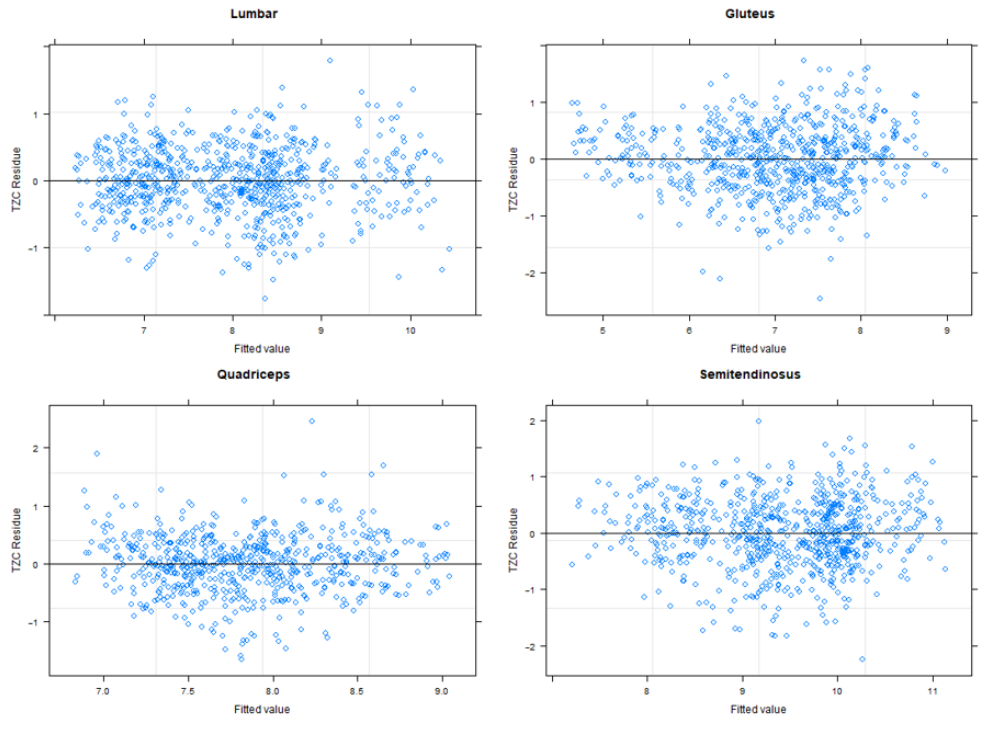
Figure A2. Plot of residues, fitted values minus observed values, over the fitted values for TZC for each muscle mixed